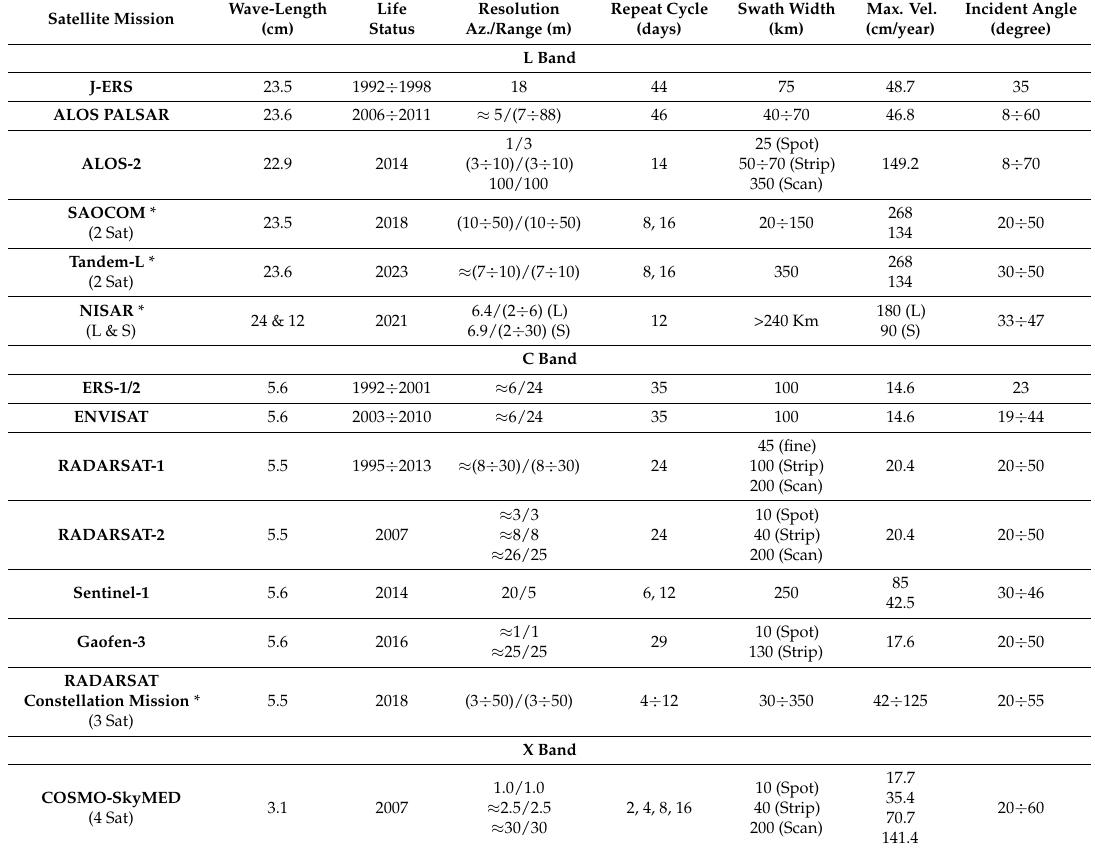
Table 1. List of some satellite SAR missions and relevant parameters (updated from [3]). Satellite